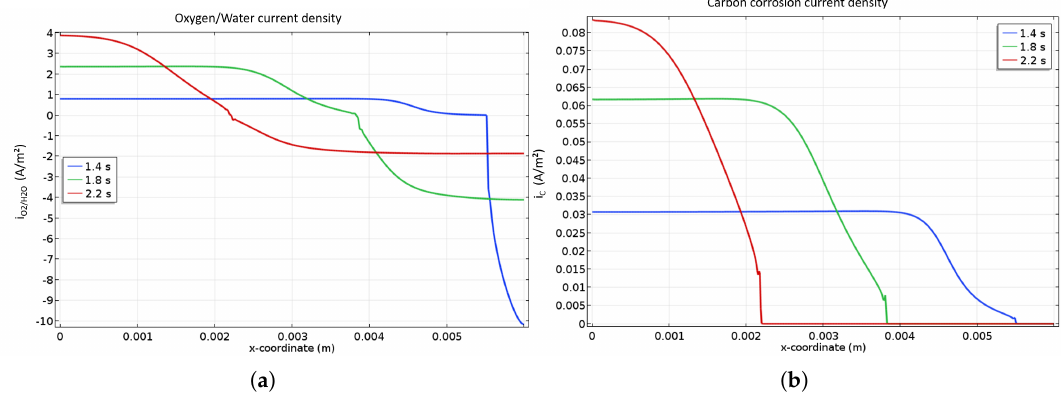
Figure 4. OER and ORR ( a ) and COR ( b ) current densities along the cathode catalyst layer during a startup. A focus is done on the most interesting and representative time periods for the described